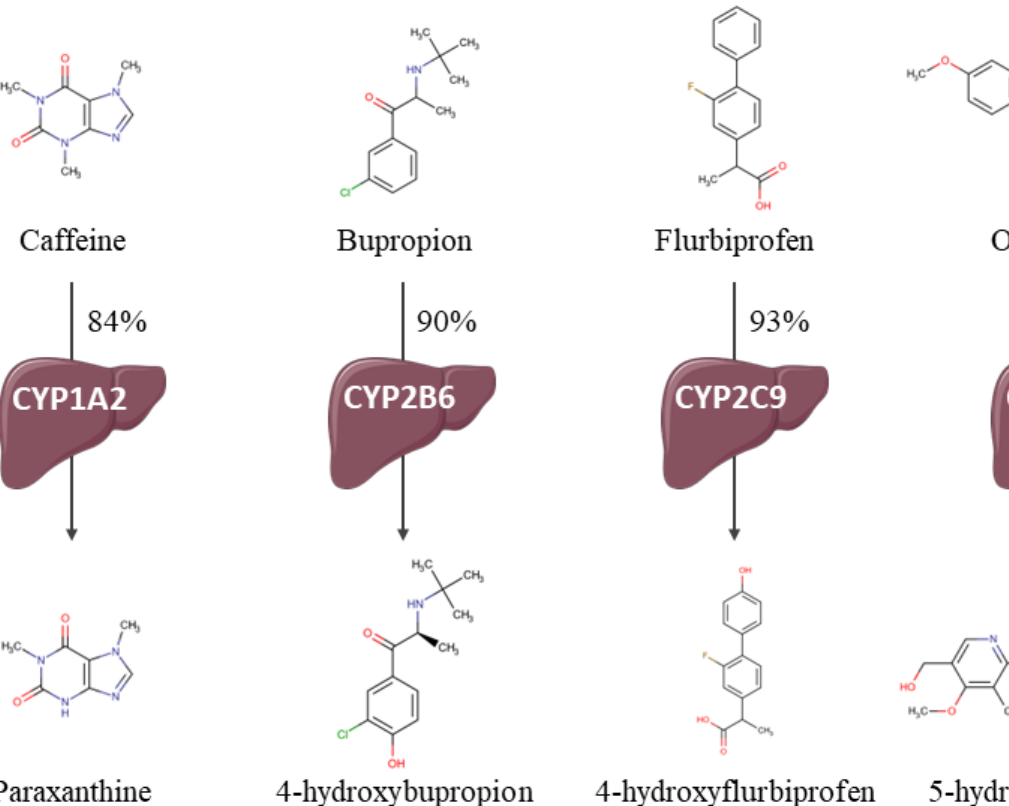
Figure A1. Cocktail drug metabolizations by the assessed CYP and chemical structures of probes and metabolites.